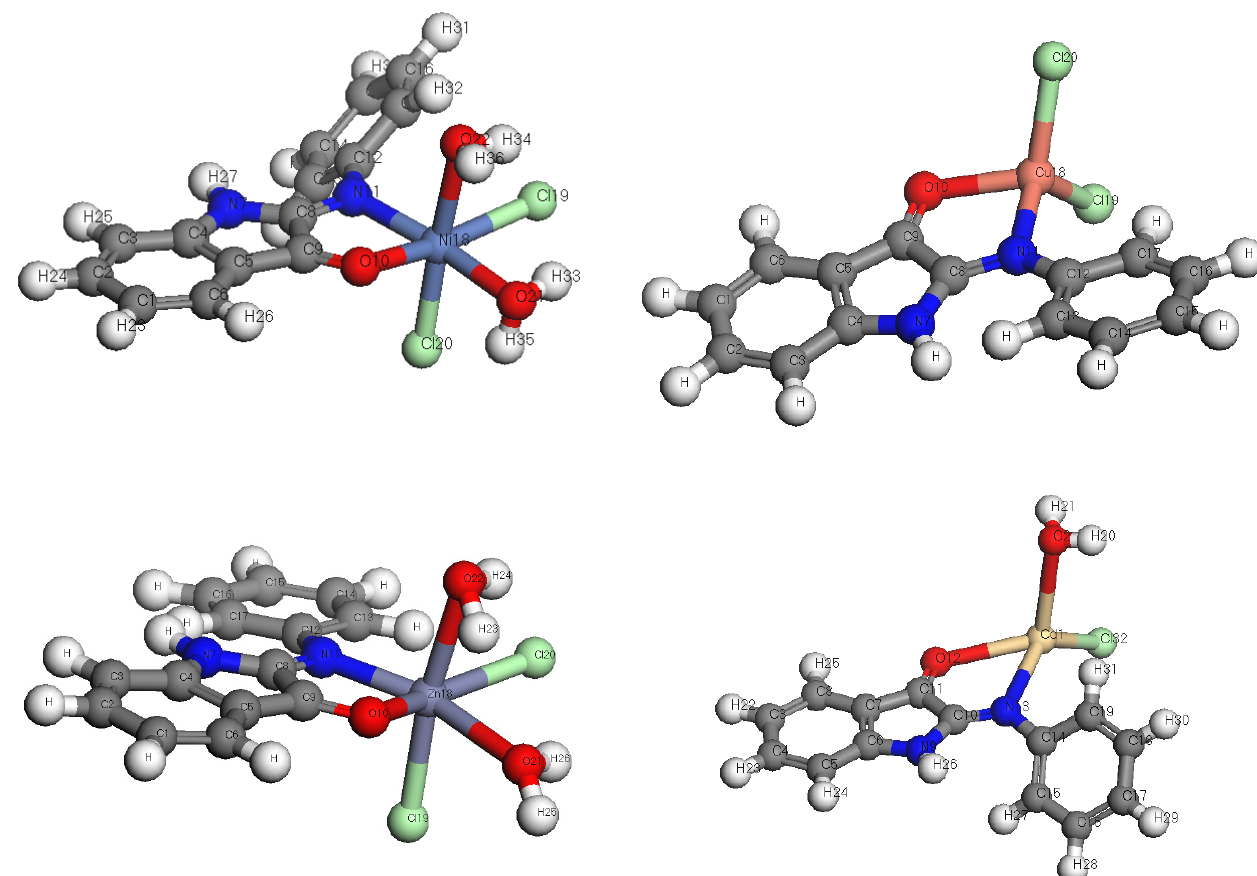
Figure 3. Optimized geometrical structures of L, Cr(III), Mn(II), Fe(III), Co(II), Ni(II), Cu(II), Zn(II), and Cd(II) complexes. Table 3. Total energy (kcal/mol), binding energy (kcal/mol), heat capacity (Cp), entropy (S) (cal/mol-kelvin), enthalpy, free energy (kcal/mol), and dipole moment (Debye) of ligand, Cr(III),